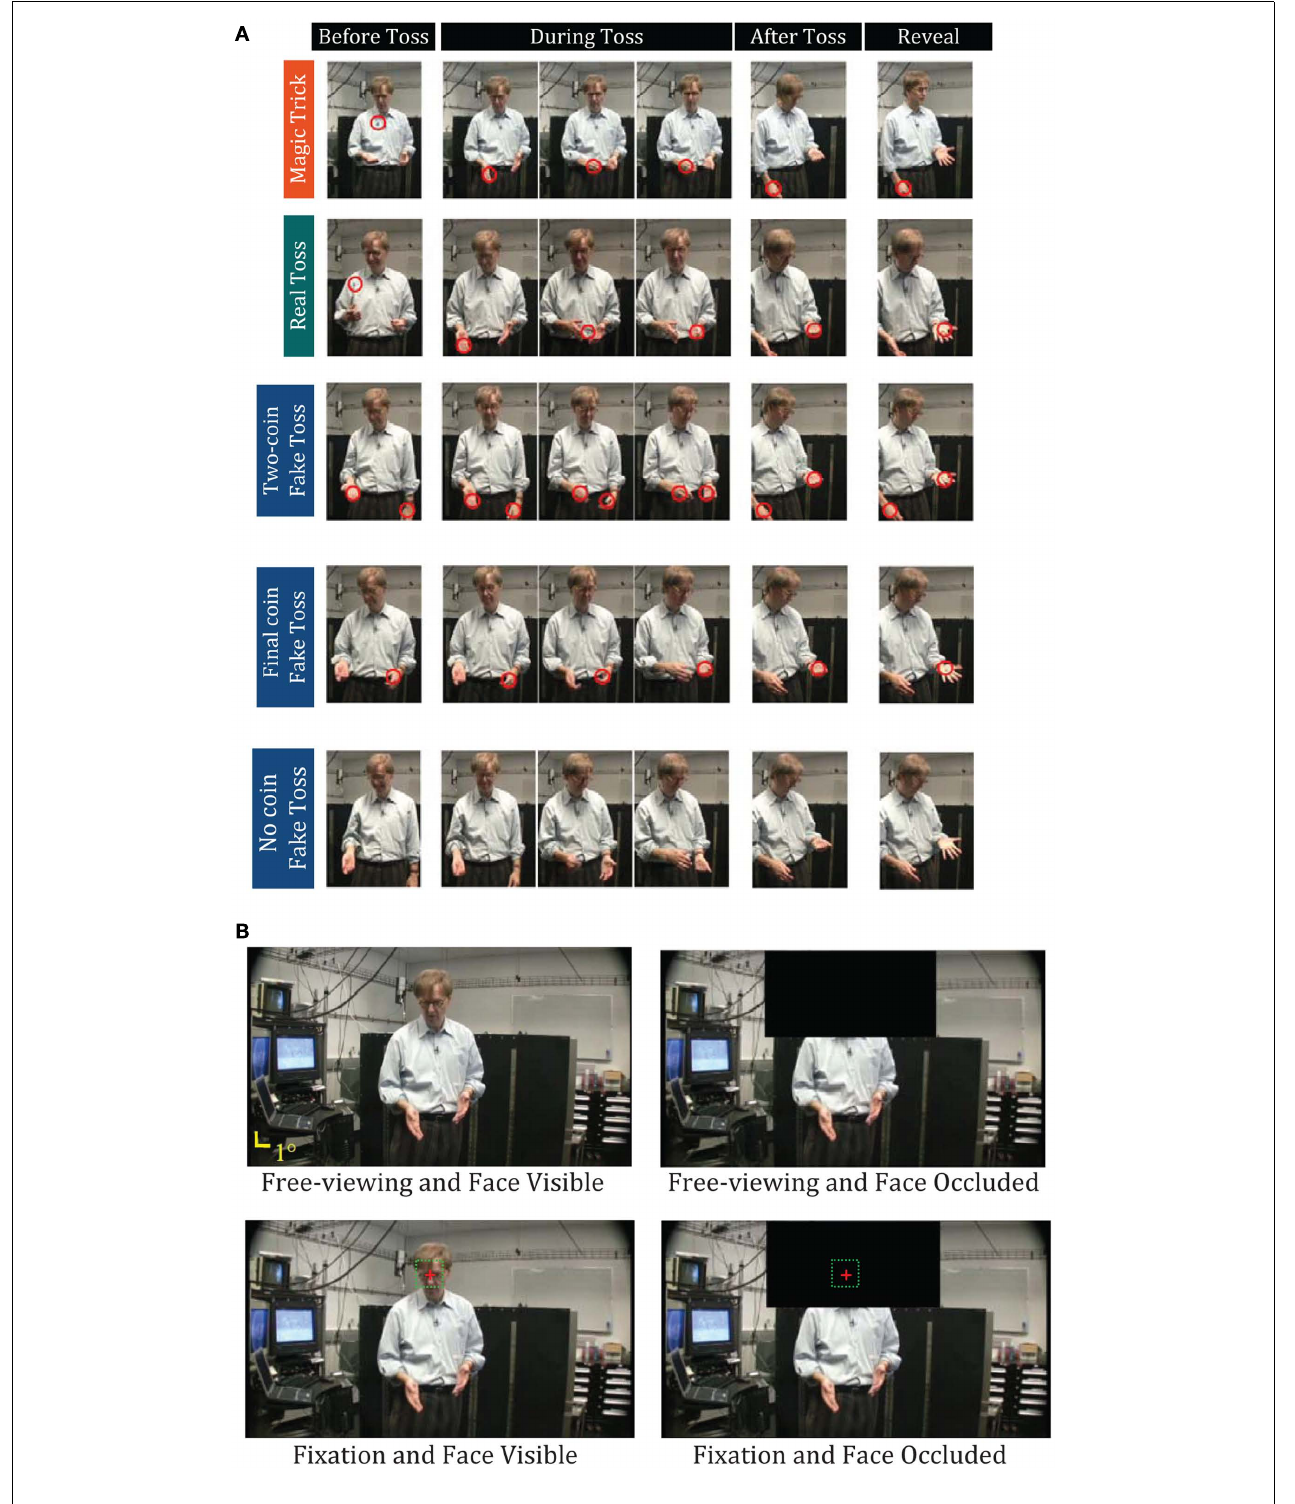
Free-exploration (Upper Row) and fixation (Lower Row) viewing conditions. Green dotted boxes (Lower Row) indicate the 2˚ × 2˚ fixation window; fixation cross not to scale. Left and Right Columns: Magician’s face visible (Left Column) and occluded (Right Column).